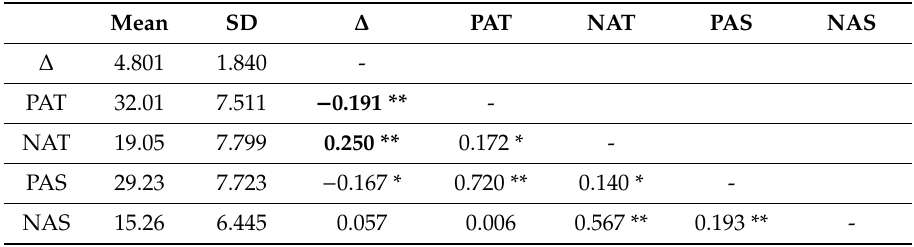
Table 5. Pearson correlations of ∆ / PANAS Trait and ∆ / PANAS State.